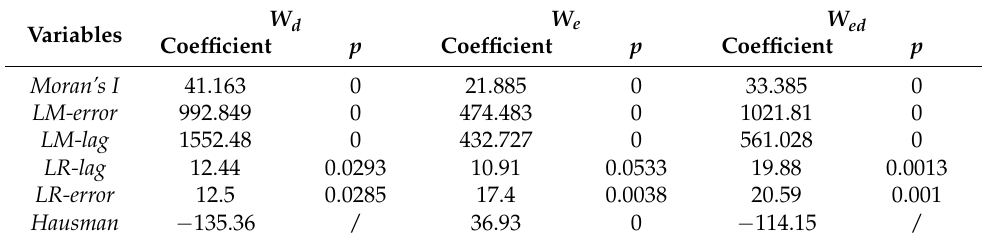
Table 3. Model test